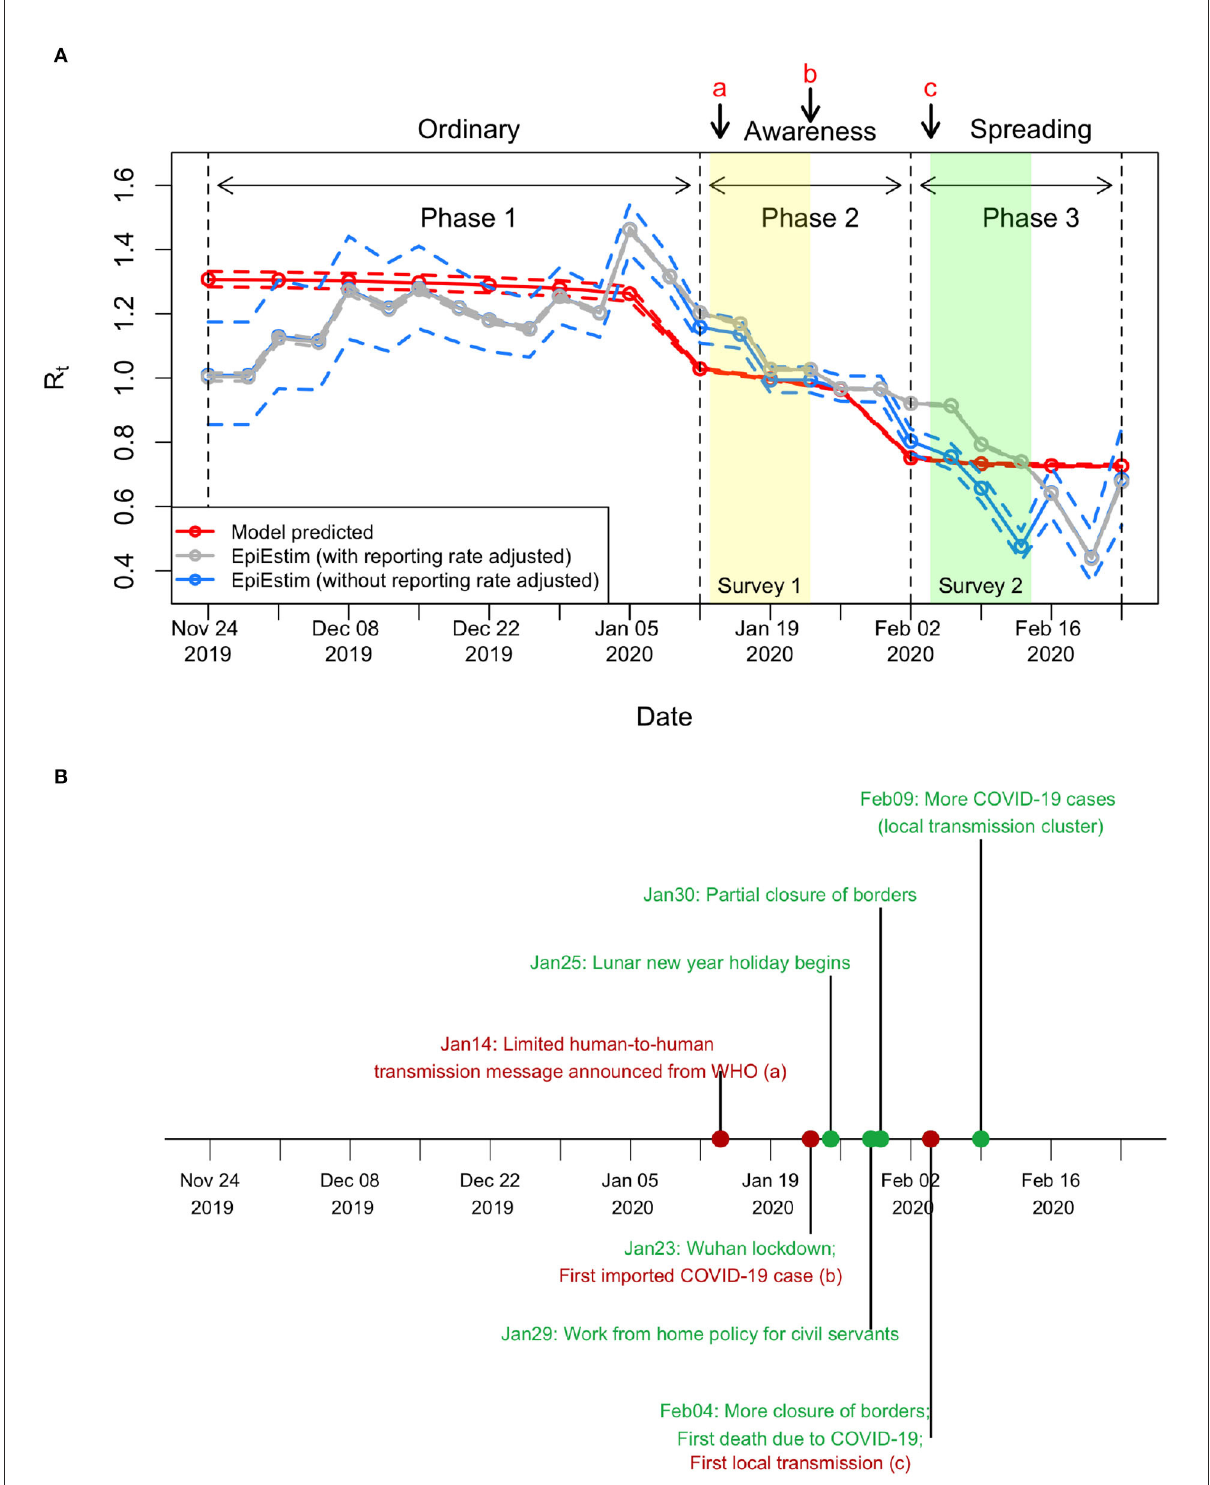
FIGURE3 Changes in R t before COVID-19 outbreak. (A) Estimated R t in 2019/20 winter influenza season. The mean R t was estimated as 1.29 (95%CI, 1.27–1.32) in Phase 1, reduced to 1.00 (95%CI, 0.99–1.00) in Phase 2, and further reduced to 0.73 (95%CI, 0.73–0.74) in Phase 3. In applying EpiEstim package, the number of influenza cases per week was converted into cases per 3.5 days by linear interpolation on the cumulative influenza cases, which equals to roughly one generation time of influenza (30). For other settings in applying the EpiEstim package, the serial interval was a gamma distribution with the mean equal to 3.5 days and the standard deviation equal to 1 day, and the window size was 2 weeks. (B) Timeline about COVID-19. Important events are shown in red, while other events are shown in